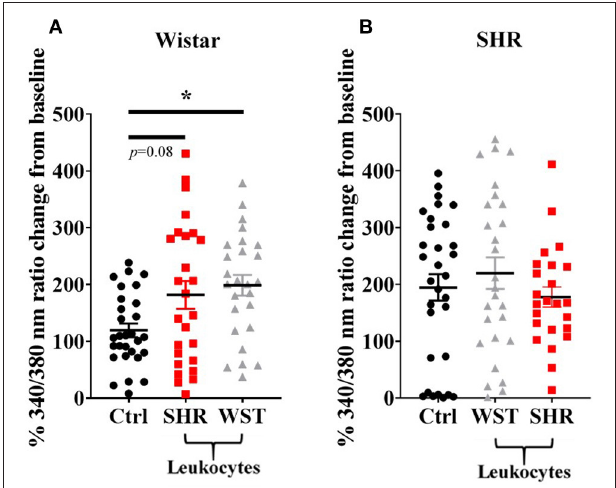
FIGURE 2 | Peak [Ca 2 + ] i transient responses of stellate neurons co-cultured with blood leukocytes in response to 100 µ M nicotine: (A) Wistar neurons (with SHR leukocytes: n = 26 neurons, 3 cultures, 2–3 rats per culture; with Wistar leukocytes: n = 26 neurons, 3 cultures, 2–3 rats per culture) and (B) SHR neurons (with Wistar leukocytes: n = 27 neurons, 3 cultures, 2–3 rats per culture; with SHR leukocytes: n = 24 neurons, 3 cultures, 2-3 rats per culture). Data are presented as mean ± SEM; * signifies p < 0.05 between the indicated groups; normal data were analyzed using Brown-Forsythe and Welch’s ANOVAs with Dunnett’s T3 multiple comparisons test, while non-normal data were analyses with a Kruskall-Wallis test followed by Dunn’s multiple comparisons